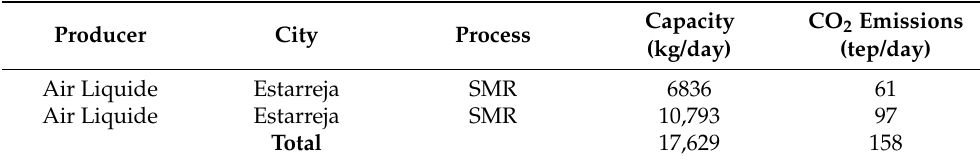
Figure 5. Evolution of natural gas consumption for hydrogen production in Portugal [55]. Table 5. Hydrogen production capacity in Portugal [61].